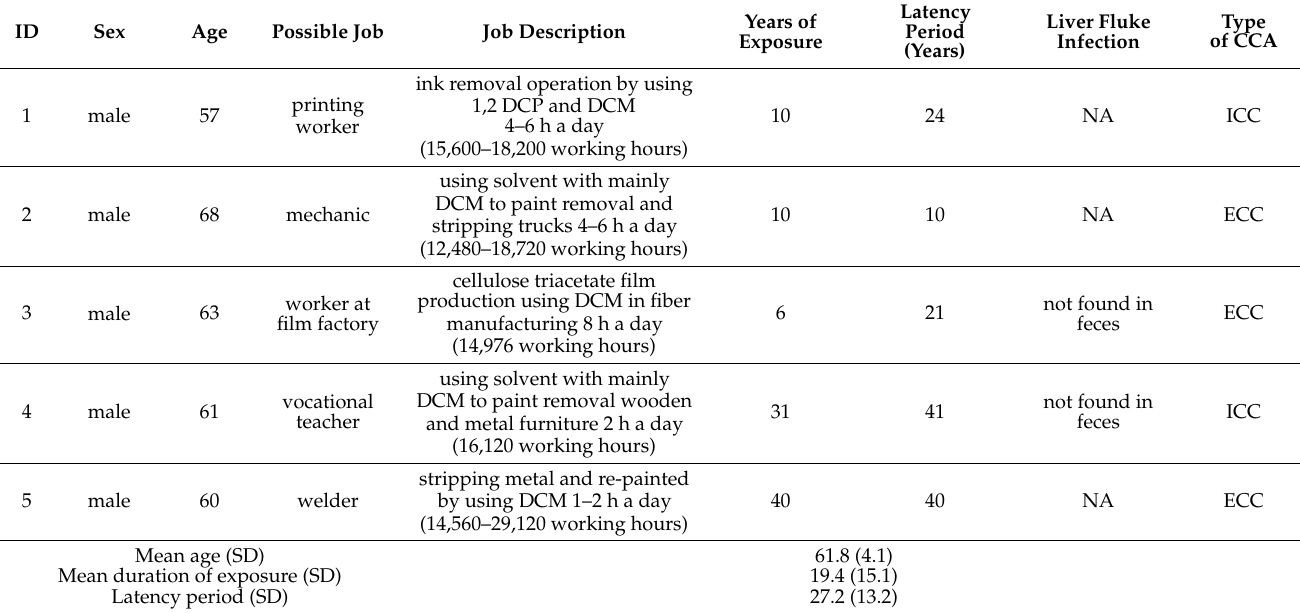
Table 3. Characteristics of participants exposed to 1,2-DCP and DCM diagnosed as possible occupa- tionally related CCA ( n = 5).